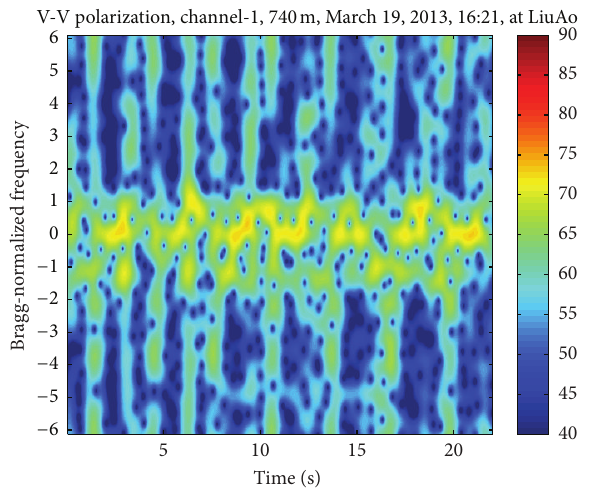
Figure 5: Echo time-frequency spectrogram with WTC aliasing.